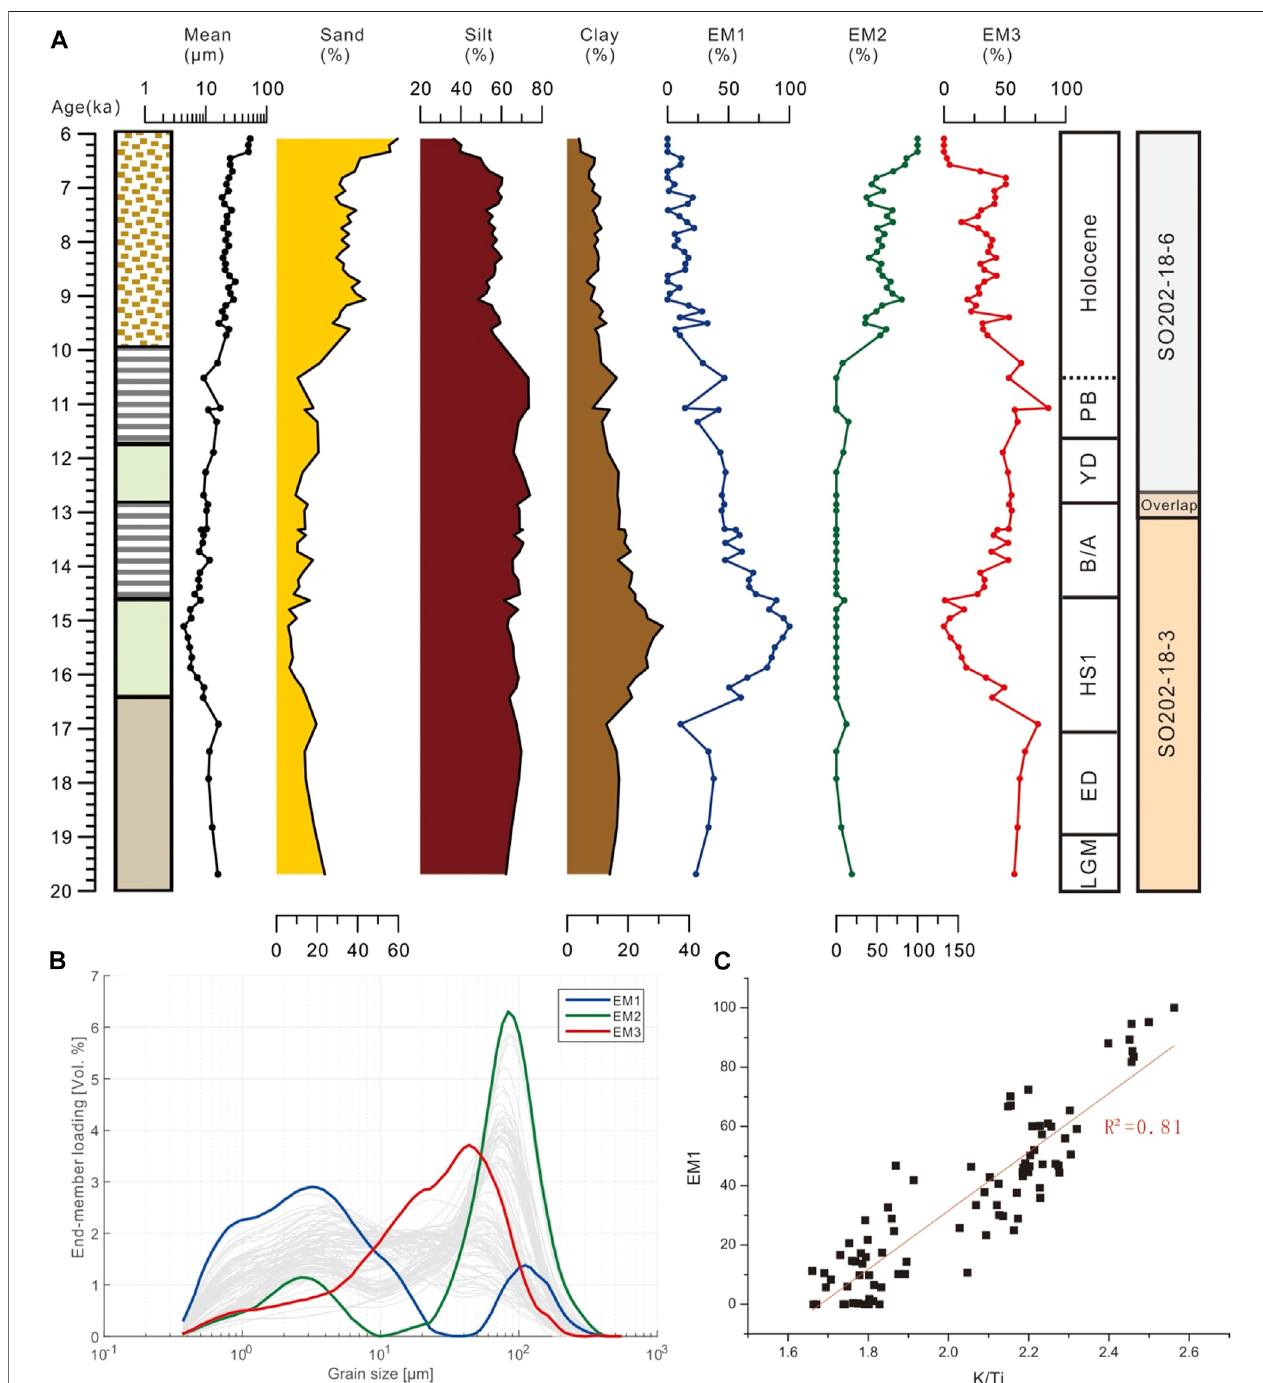
FIGURE 3 | (A) Composite section of sediment cores SO202-18-3/-6, showing downcore and temporal variations in grain-size parameters and statistical end members (EM); (B) Grain-size distributions of the three end members; (C) high positive correlation of XRF element data (Ki/Ti ratio) versus the clay-rich EM1.